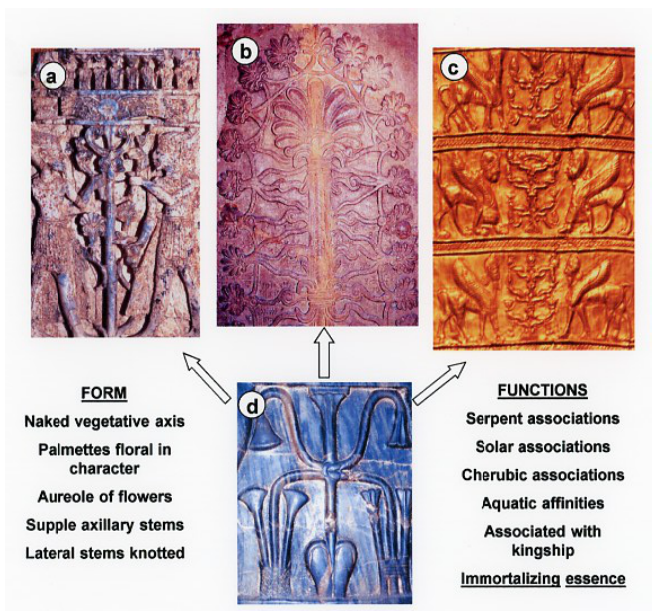
Figure 5. Shared features of the sema-taui symbol and Middle Eastern tree of life. ( a ) A Phoenician tree of life that was excavated from the Mesopotamian temple of Ashurnasirpal exhibits prominent Egyptian features: blue lotus palmettes, a blue-winged solar disk, and sun-bearing cobras. Yet the central stalk displays features of Mesopotamian trees of life: lateral palmettes, trefoil at the apex of the trunk, and corniculate lateral branches. Iraq, Nimrud, 9th c. BCE. ( b ) One of 170 sacral trees uncovered among the ruins of Ashurnasirpal II. Iraq, Nimrud, 9th c. BCE. ( c ) A series of three Perso-Aryan lotus trees of life terminate in a lotus blossom, solar motif, and lotus berry. The lateral branches of each tree support a succession of lotus buds, blossoms, and fruits. Chimeric guardians of the trees exhibit the combined aspects of a bull, lion, human, and eagle, suggesting the biblical features of a cherub. Iran, Ziwiye, 8–7th c. BCE (Metropolitan Museum). ( d ) Early Egyptian sema-taui motifs apparently served as a prototype to sacral tree imagery in the Fertile Crescent since both motifs exhibit a central stalk, terminal palmette, supple lateral stems that tie off to the plant’s central column, and surrounding palmettes. Tree of life motifs similarly graced the backs and side panels of Mesopotamia and Levantine thrones and couches, usually as decorative ivory pieces (Barnett 1982, p. 25, pls. 18a,b, 52a,c; Crowfoot and Crowfoot 1938, p. 2; Parrot 1961, p. 155). Throne of Chephren, Giza, 26th c. BCE (Cairo Museum).